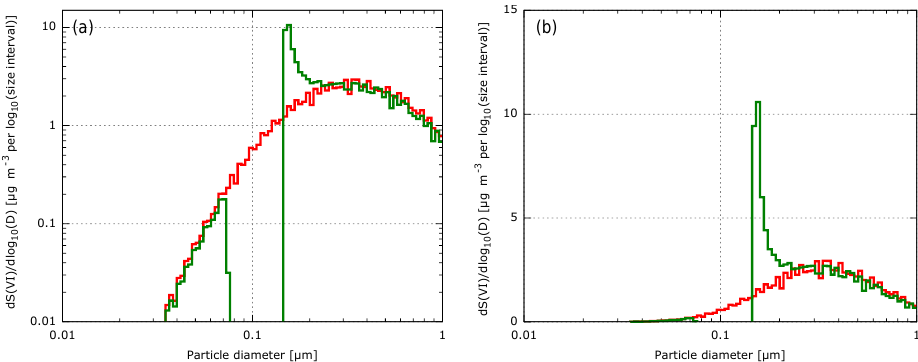
Figure 3. Modification of the dry aerosol sulfate mass. The red line shows the initial condition and the green line shows the final model state. The left panel uses a logarithmic scale and the right panel uses a linear